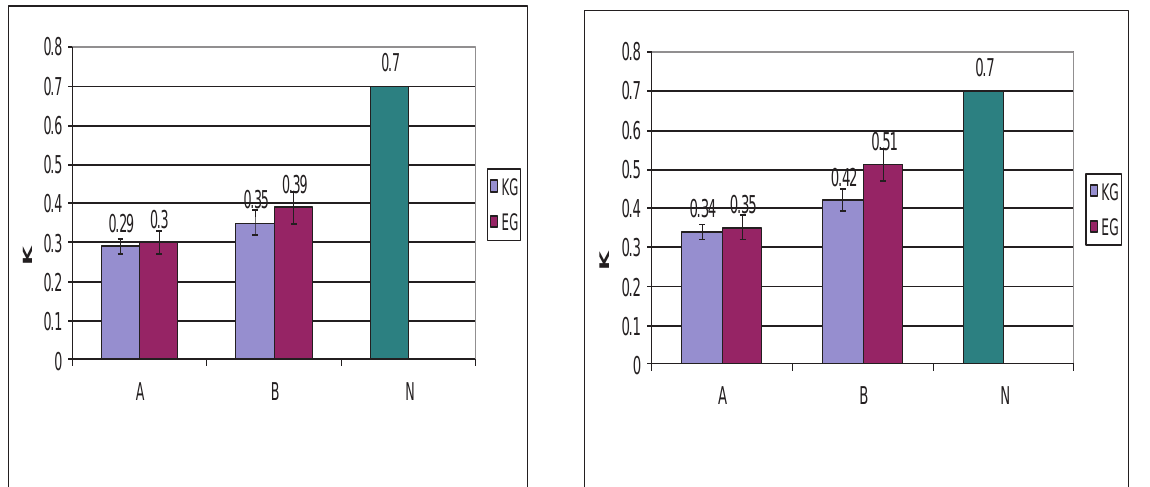
Fig. 2. The magnitude of creatinine excretion (F – g/day) in children aged 12-13 years in rest (A) and after physical culture lesson (B) (n=40): A – at the beginning of the study, B – at the end of the study, N – norm, KG – control group, EG – experimental group.